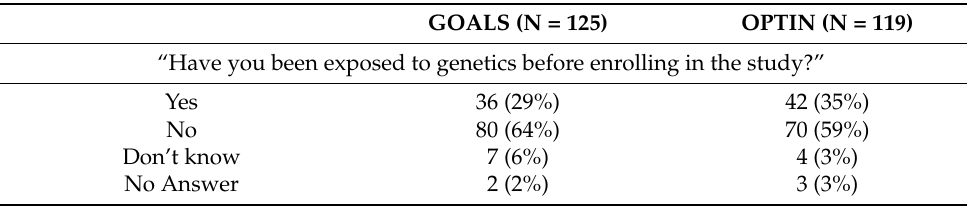
Table 2. Participant Baseline Genetic Perception Survey Results